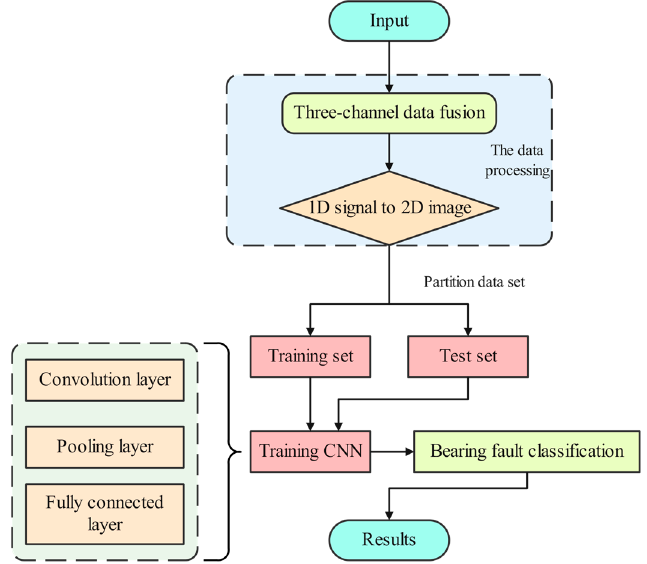
Figure 8. Flow chart of rolling bearing fault diagnosis based on a spectrum map.